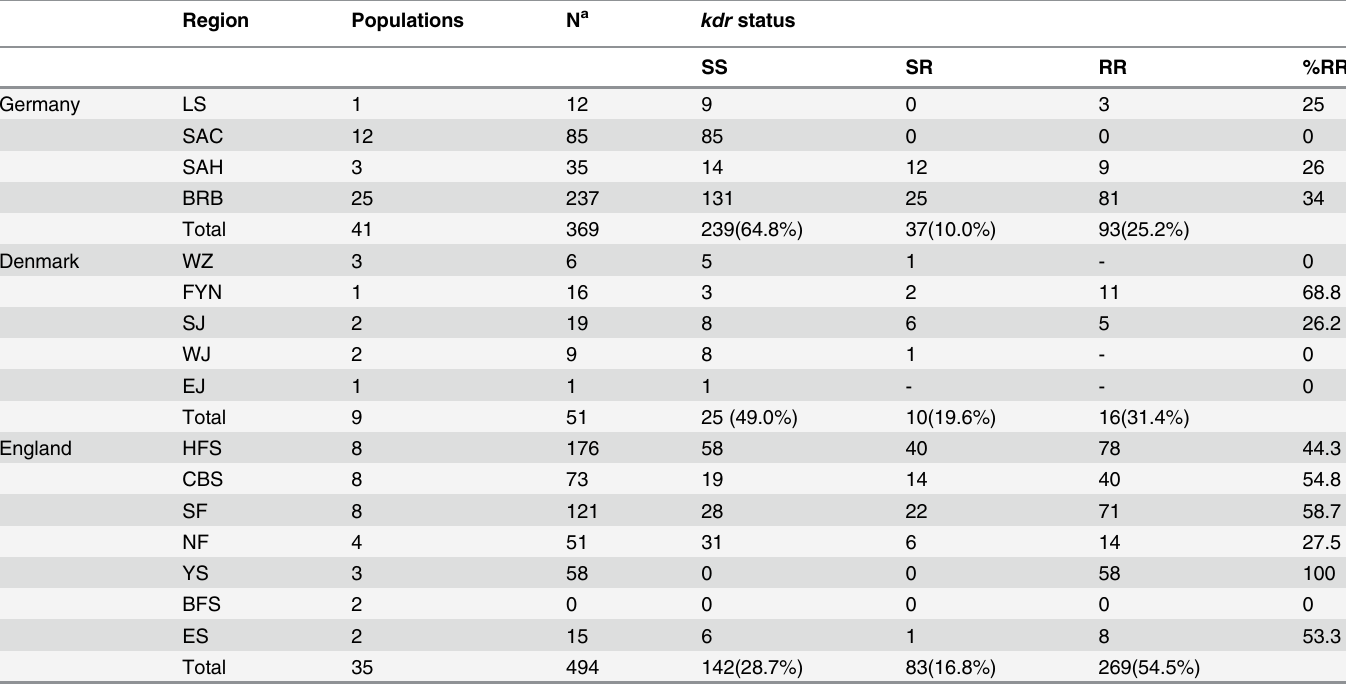
In total 41 German samples were collected from four regions, primarily from the north-east of the country (Fig 1). Bioassays performed on a few selected samples showed resistant beetles, with resistance ratios ranging from 9 to 24 based on log-dose probit-mortality data when com- pared to a susceptible strain. However, treatment with 100% of the recommended λ -cyhalo- thrin label rate still resulted in close to 100% mortality (Fig 2). In the susceptible sample, 10% Table 2. Frequencies of the kdr mutation. Populations tested. Region